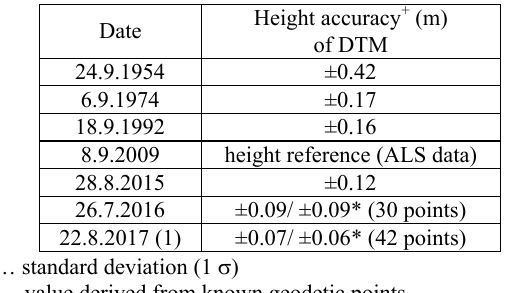
Table 6. Height accuracy of